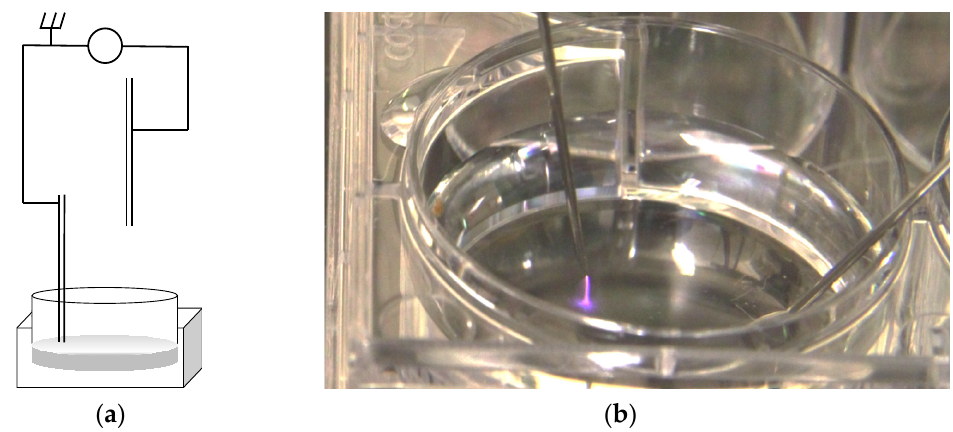
Figure 1. ( a ) Schematic representation of the apparatus constructed for cell culture CAP irradiation. ( b ) Photograph of a cell culture multi-well plate being irradiated, showing the plasma plume.